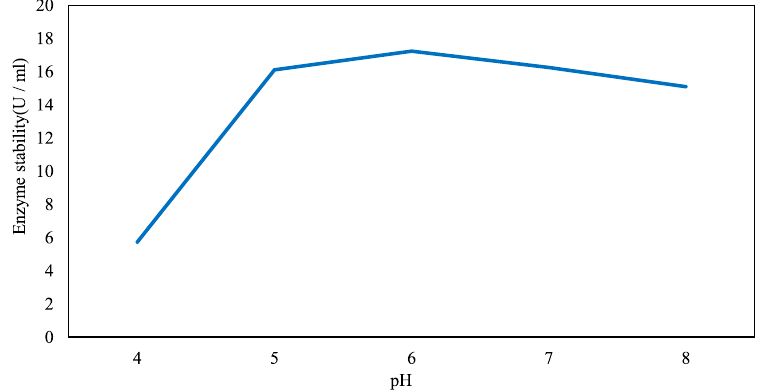
Fig. 11. Effect of different pH values on activity of the purified β-xylosidase